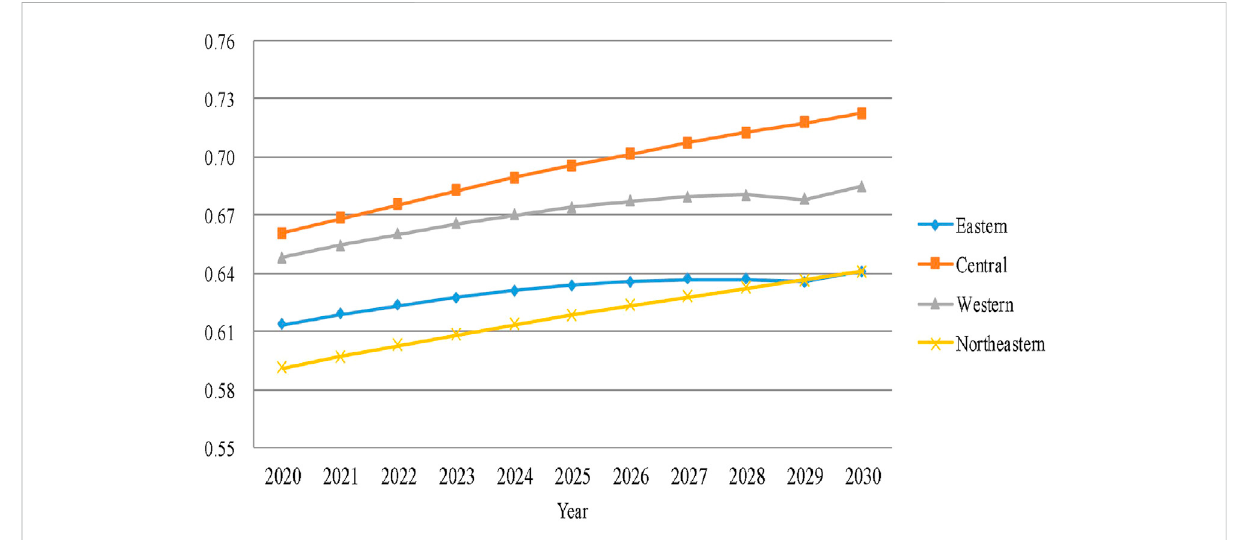
FIGURE 4 Prediction of the coupling coordination degree from 2020 to